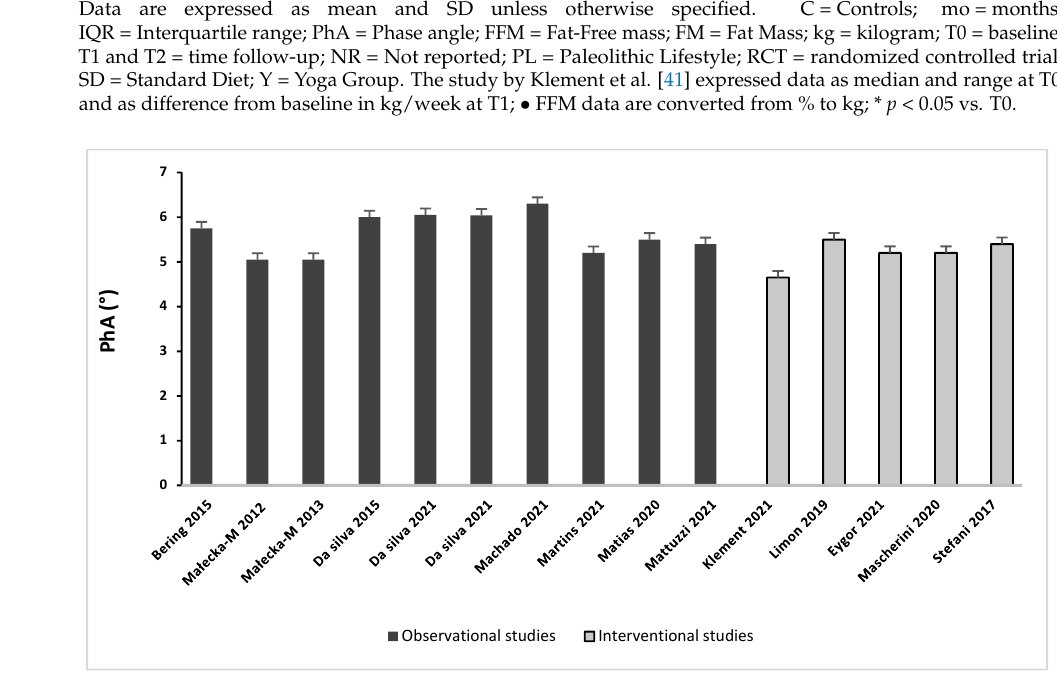
Figure 2. Baseline PhA values in patients with BC.